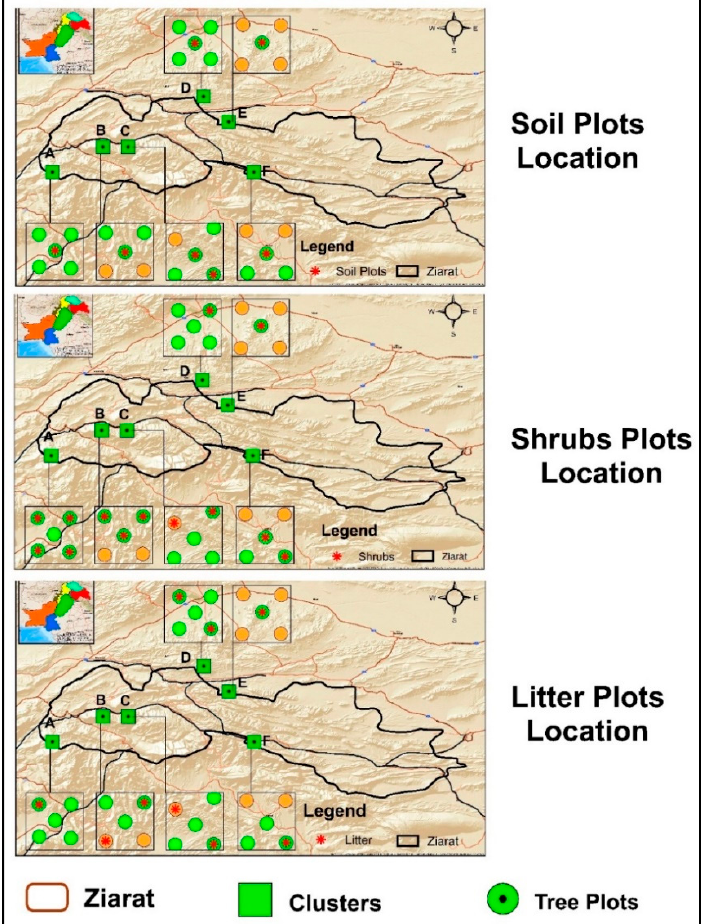
Figure 2. Location of tree plots, soil samples, shrubs samples and litter samples in the study area. The above-ground biomass was calculated for all the plots, however, only one soil sample was collected from the primary plot of each cluster thus giving us six soil samples. Plots for above-ground biomass, shrubs, litter and soil had a radius of 17.8 m, 5.64 m, 0.56 m respectively, keeping in mind that soil and litter plots have the same radius.